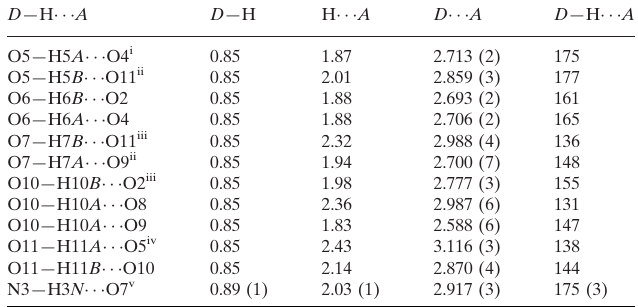
Hydrogen-bond geometry (A˚ , (cid:3) ). D —H (cid:2)(cid:2)(cid:2)